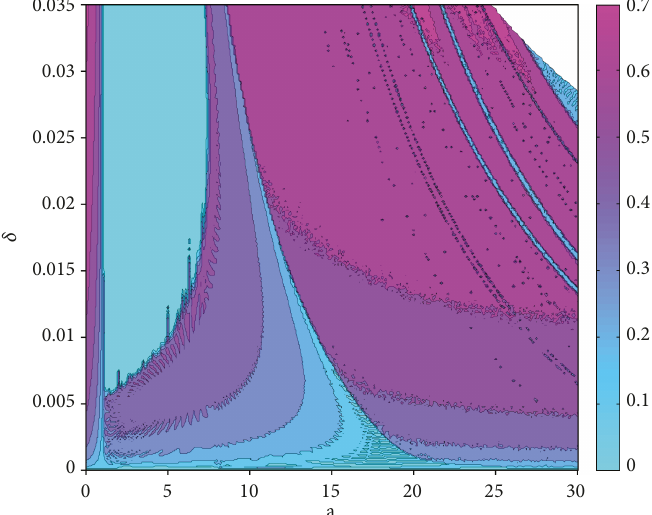
Figure 7: The spectral entropy complexity of system (2) with b = 3 in the a − δ parameter